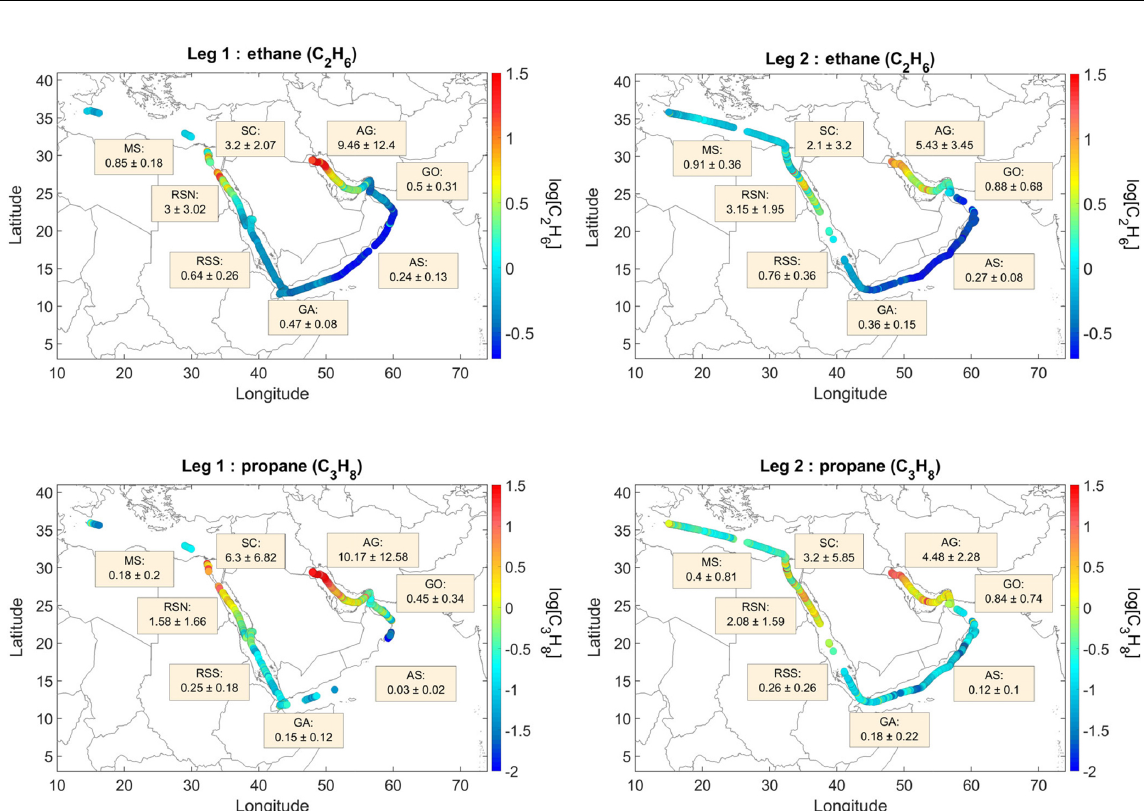
Figure 2. Ethane and propane volume mixing ratios during AQABA. Average mixing ratios ± standard deviation (in ppb) for each area and leg. More detailed statistics are provided in the Supplement (Figs. S3–S4) and in Table